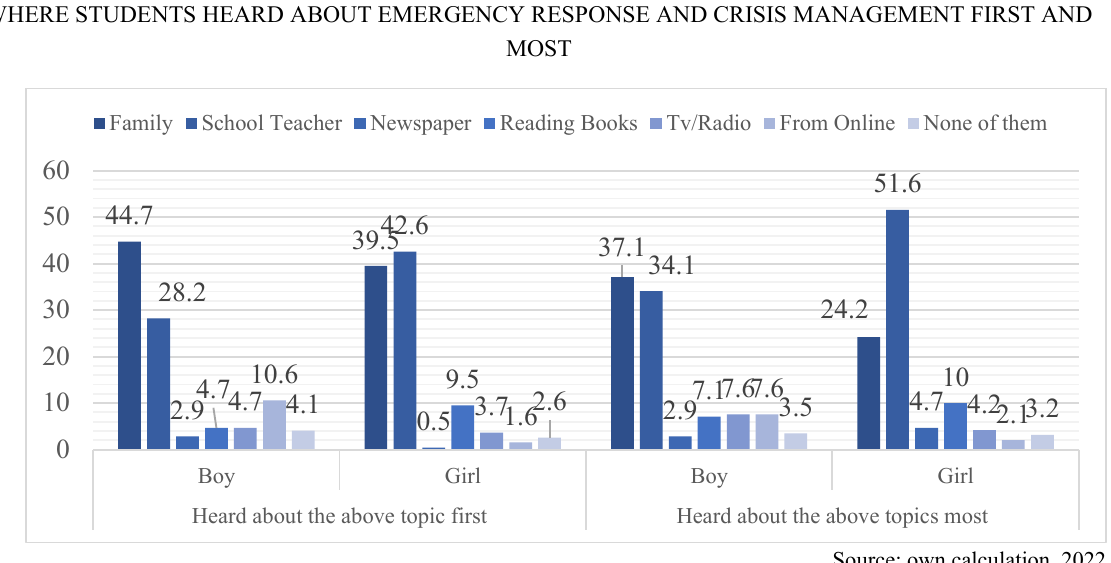
F IGURE 5. PERCENTAGE DISTRIBUTION OF THE KNOWLEDGE LEVEL OF RESPONDENTS